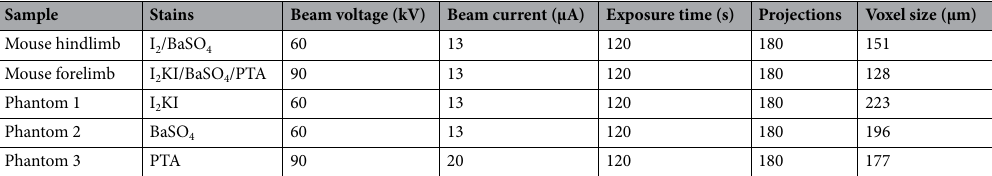
Table 1. Sample preparation and scan settings. A full list of the different contrast agents and scan settings for each biological sample and phantom examined in this